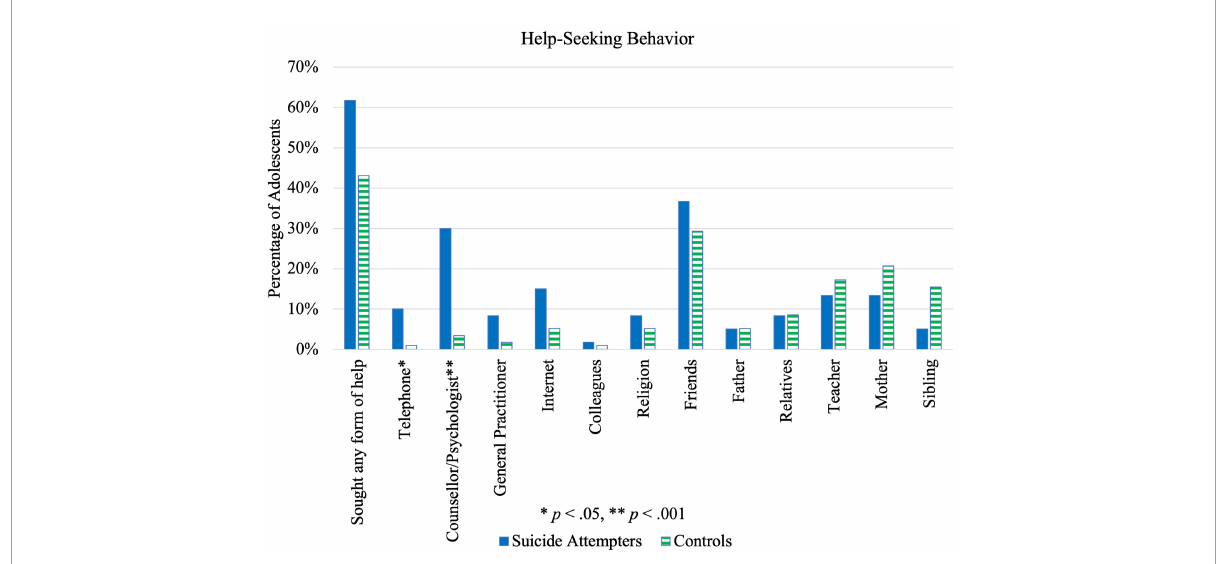
FIGURE6 Illustration of differences in help-seeking behavior between suicide attempters and control